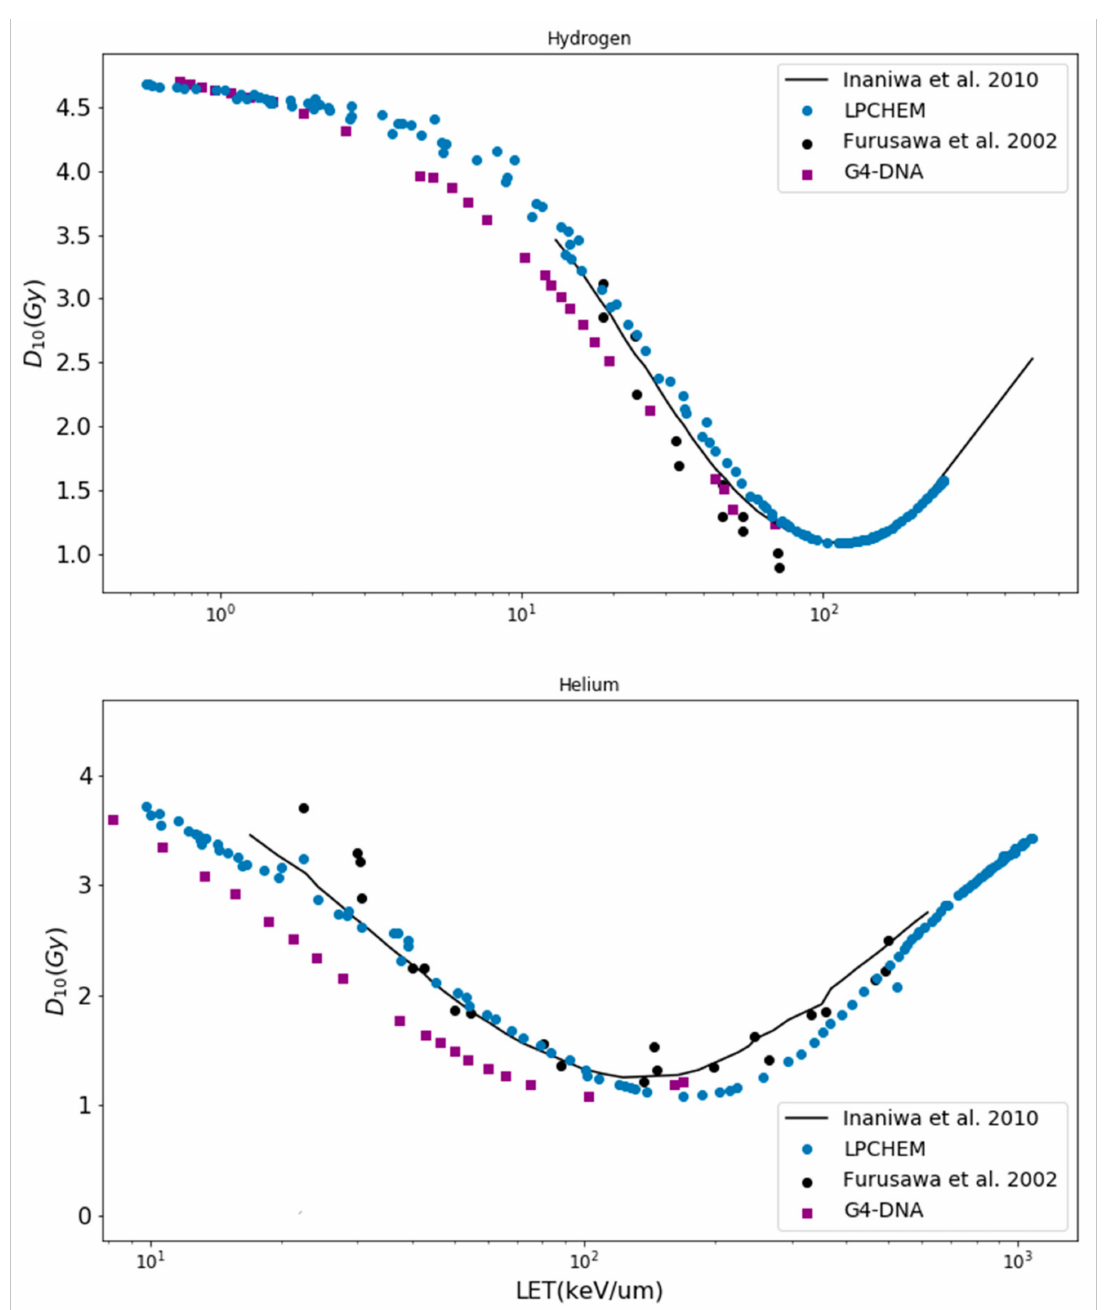
Figure 3. D 10 values under aerobic conditions as a function of LET for helium and carbon beams for HSG cells. Geant4-DNA and LPCHEM were compared with the values from Inaniwa et al. [24] (using the track of the Kiefer–Chatterjee model) and the experimental data from Furusawa et al.